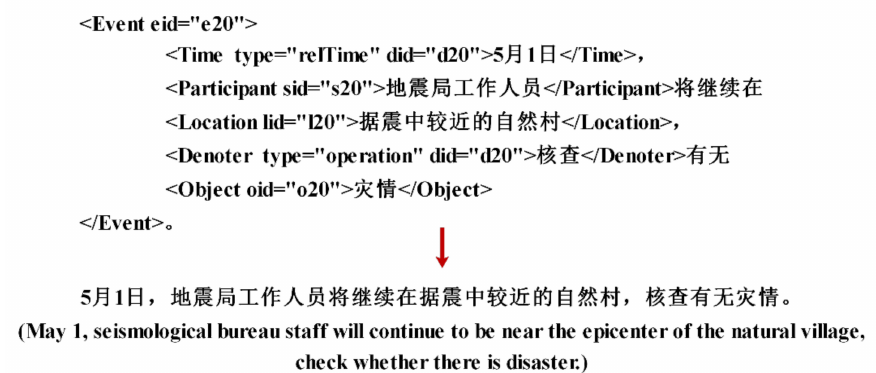
Figure 3. An example of CEC corpus in the XML language format.